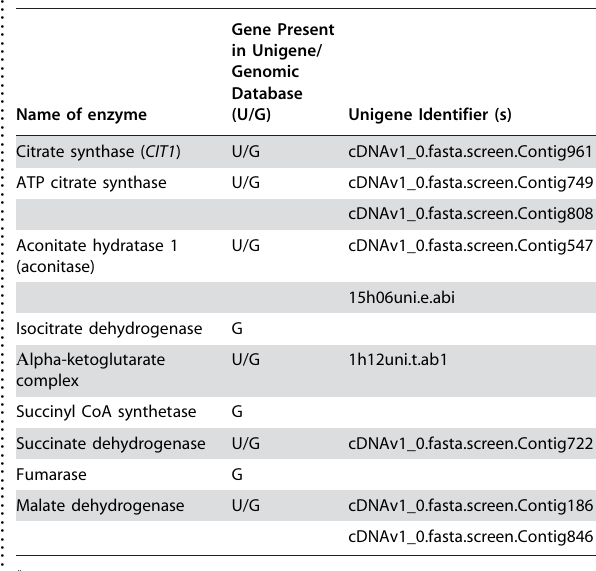
Table 5. Unigenes represented in the Citrate Cycle (TCA). .. ... .... ... ... .... ... ... .... ... ... .... ... ... .... ... ... .... ... ... .... .